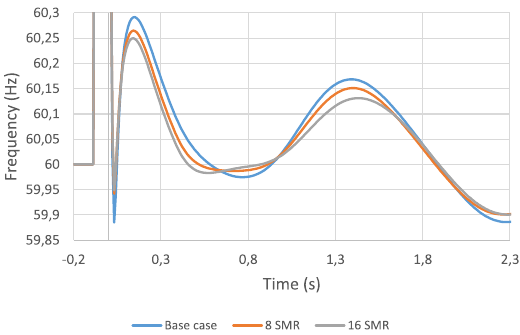
Fig. 13. Evolution of frequency at bus 19 with different num- ber of SMR in the grid.